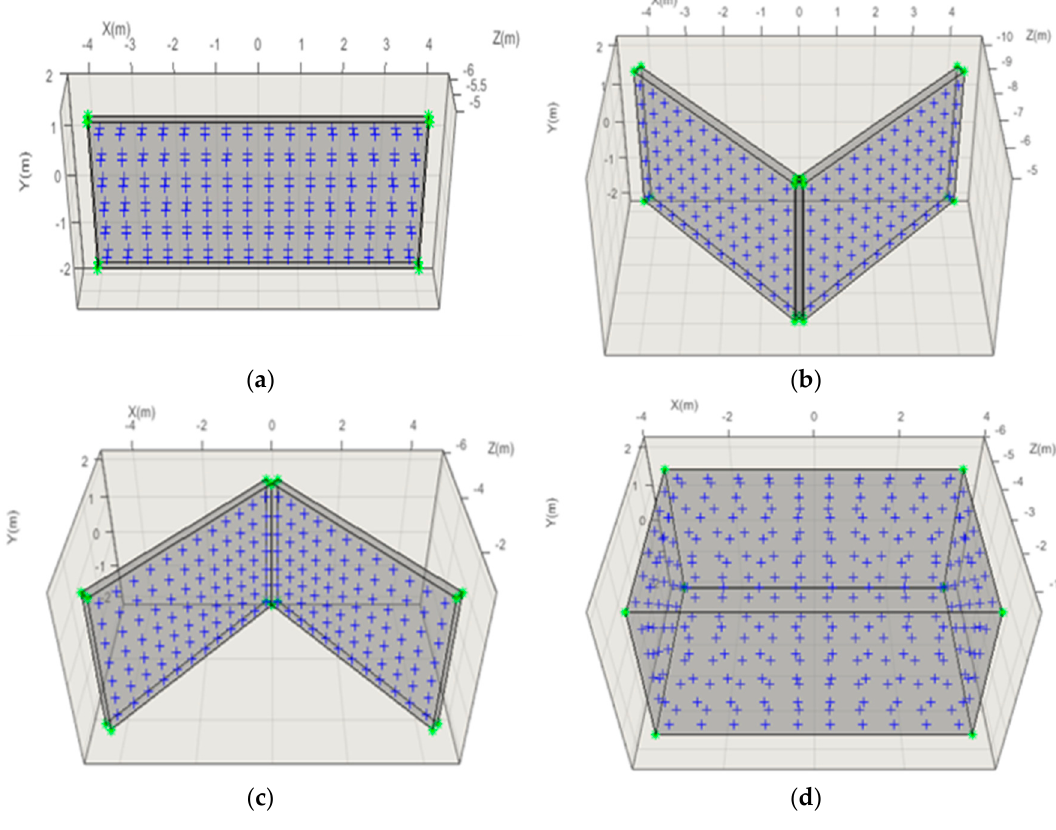
Figure 4. Test object shapes: ( a ) Plane-, ( b ) V-, ( c ) A-, and ( d ) Room-type. Table 3. Specification of camera in self-calibration simulation.